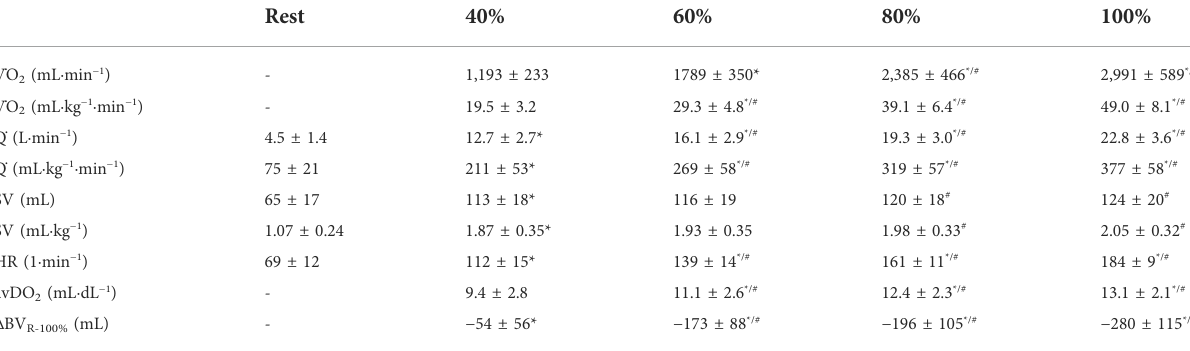
TABLE 3 Cardio-pulmonary data at rest and at different percentages of V _ O 2max . Rest